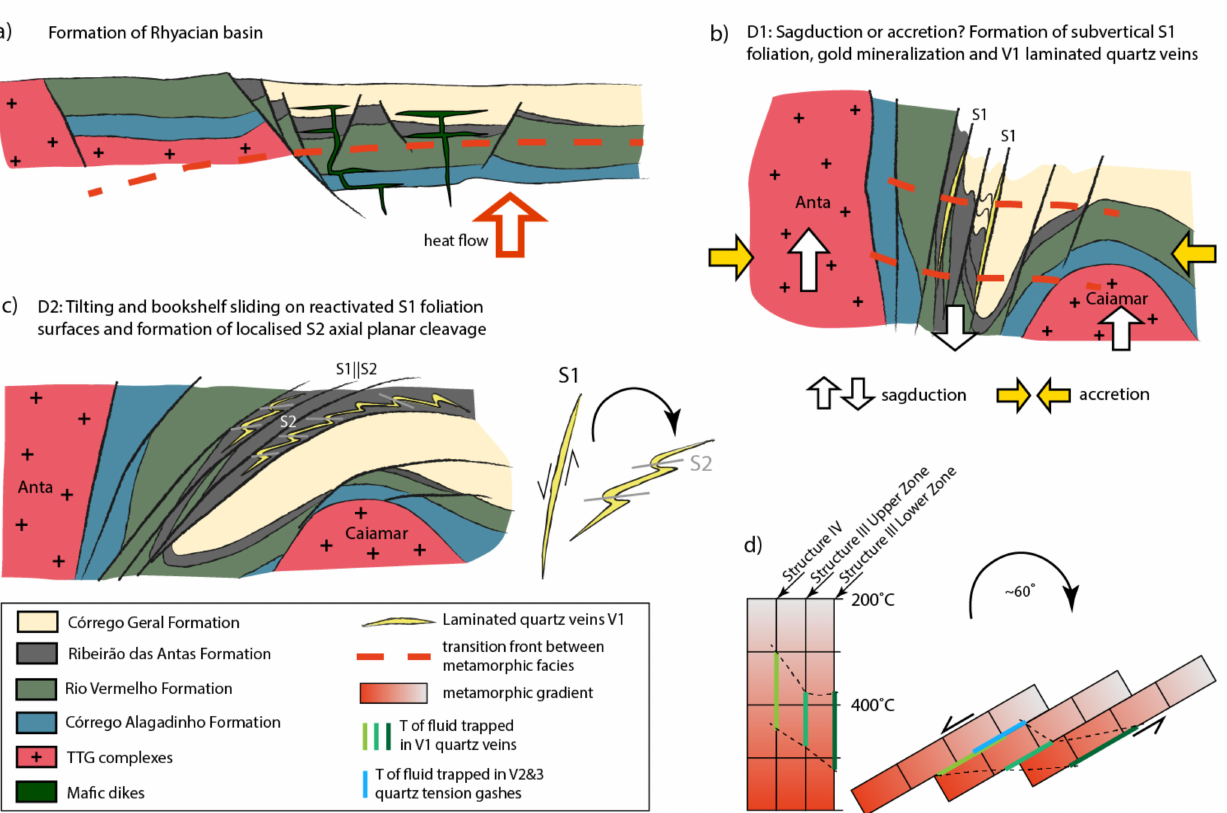
Figure 13. ( a ) Not-to-scale sketch of the tectonic setting of the Rhyacian basin before the Paleoproterozoic Orogeny; ( b ) Sagduction and the formation of sulfide-rich orebodies and laminated quartz veins (D1); ( c ) Development of high-grade ore shoots via localized F2 folding, tilting and overturning of the Crix á s Greenstone Belt stratigraphy (D2); ( d ) Temperature ranges of trapped hydrothermal fluids during D1 (shades of green) are projected on the individual ‘Structures’ (left). The bookshelf sliding model of tilted D1 geotherm and temperature range of trapped hydrothermal fluid during D2 (blue) explains the recent juxtaposition of the trapping